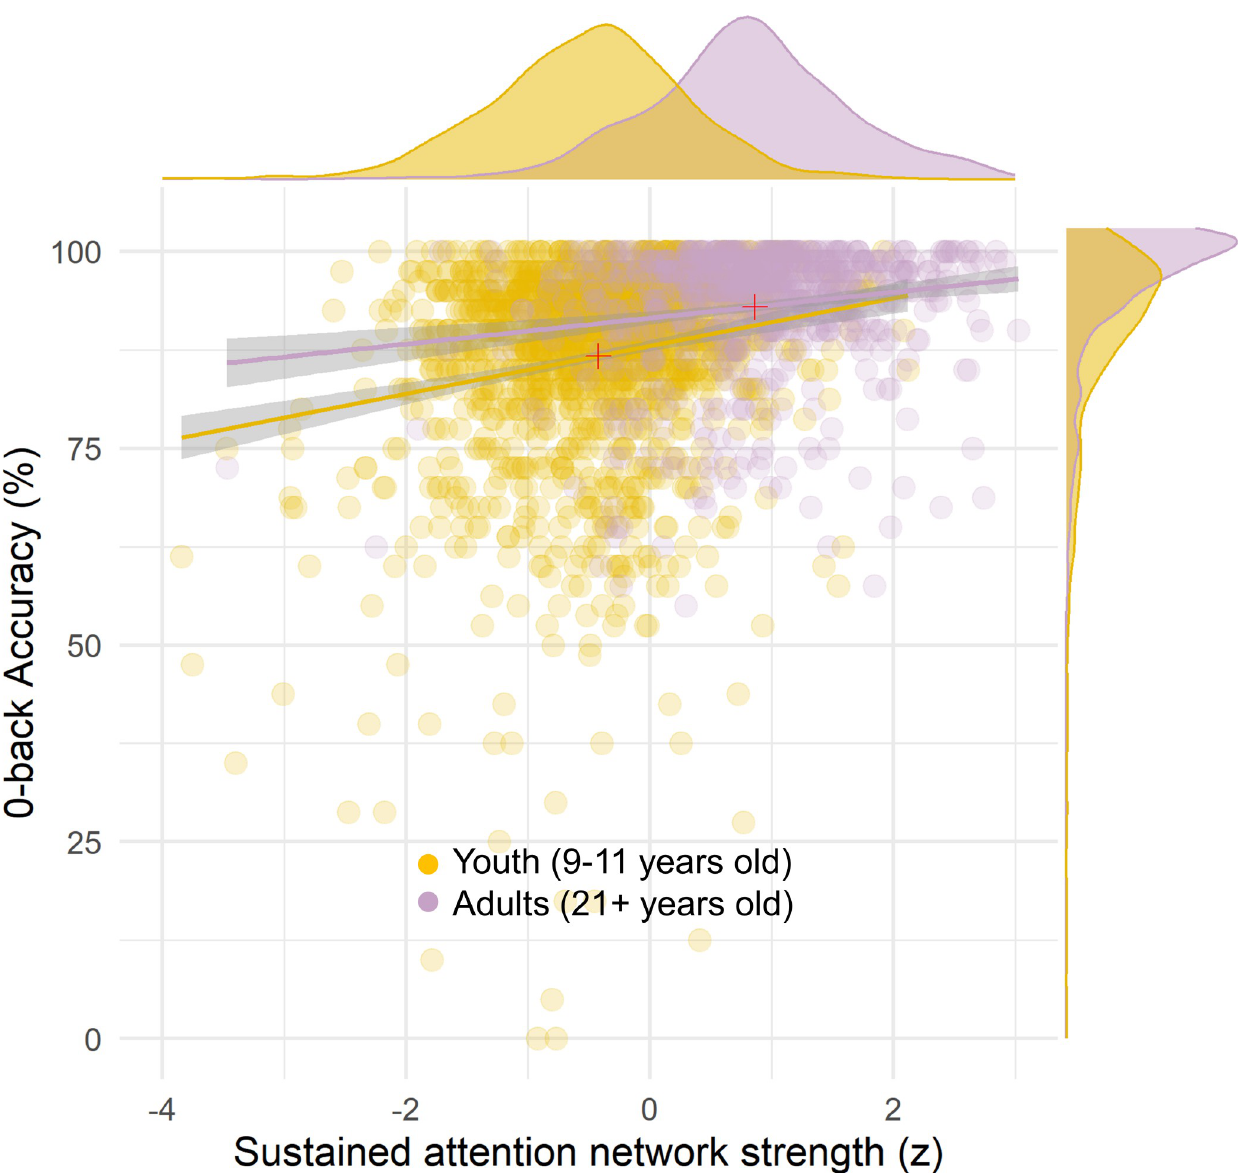
Fig 6. The strength of the adult SA network predicts 0-back accuracy in youth and novel adults. Even though the discriminability of individuals’ task performance is not significantly different within each dataset, i.e., there is no significant difference between the correlations (ABCD = gold, r = 0.19, ρ = 0.15, ps < 0.001; HCP = violet, r = 0.17, ρ = 0.12, ps < 0.001; difference between r s is not significant Z = 0.46, p = 0.456), the mean performance and mean network strength are both significantly larger in adults. Overall, adults show stronger SA networks and better 0-back performance than youth (red + signs show the mean of SA strength and 0-back accuracy for the scatterplots in each dataset). The data for this figure are available at NDA study 1849 10.15154/ 1528288. ABCD, Adolescent Brain Cognitive Development; HCP, Human Connectome Project; SA, sustained